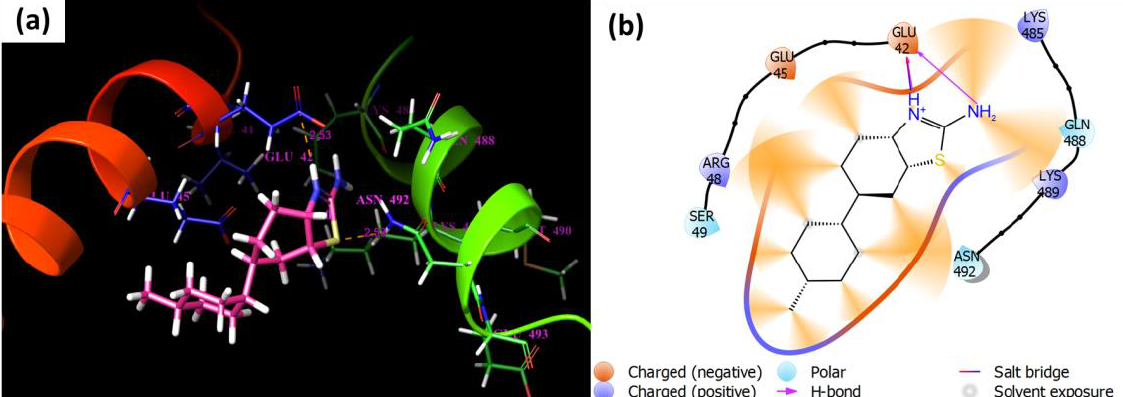
Figure 9. ( a ). Molecular docking of 7EL1 with ligand 1 . ( b ). Two-dimensional structure, hydrogen bonds, hydrophobic and other interactions.